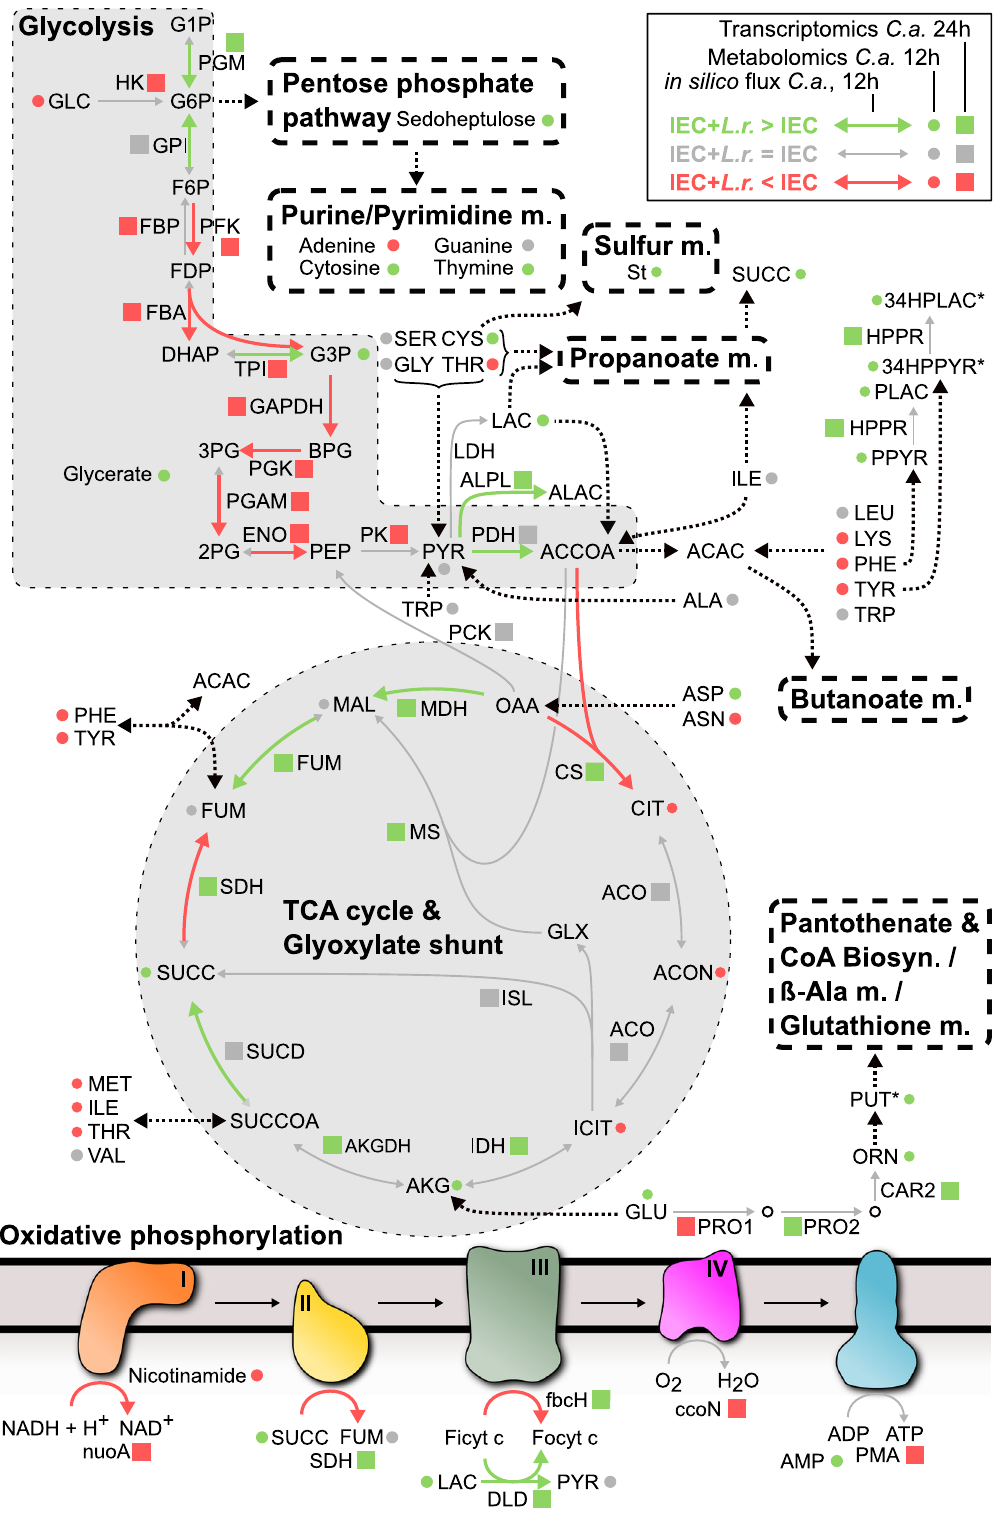
Fig. 6 Central metabolism of C. albicans is altered by L. rhamnosus colonization. Reactions associated to glycolysis, TCA cycle, oxidative phosphorylation are indicated, as well as relationships with additional metabolic pathways (pentose phosphate pathway, nitrogenated bases, sulfur metabolism, butanoate, propanoate, and pantothenate, CoA, β -Alanine and glutathione metabolism). Information on metabolome (12 h) and transcriptomic (24 h) data are combined with in silico genome-wide metabolic fl ux predictions (12 h). Dotted arrows represent several combined reactions. For the reaction abbreviations see Table